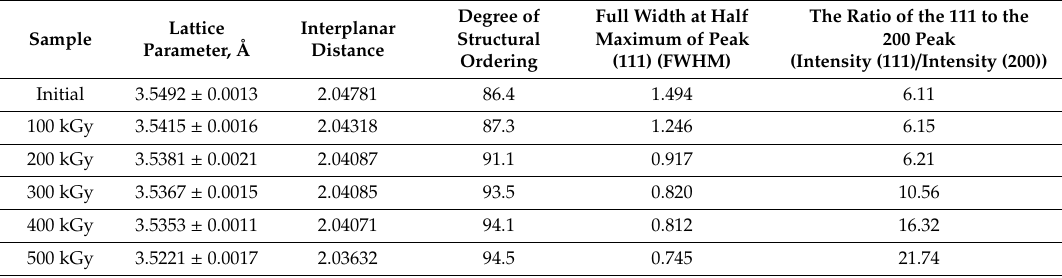
Table 1. Data on changes in crystallographic